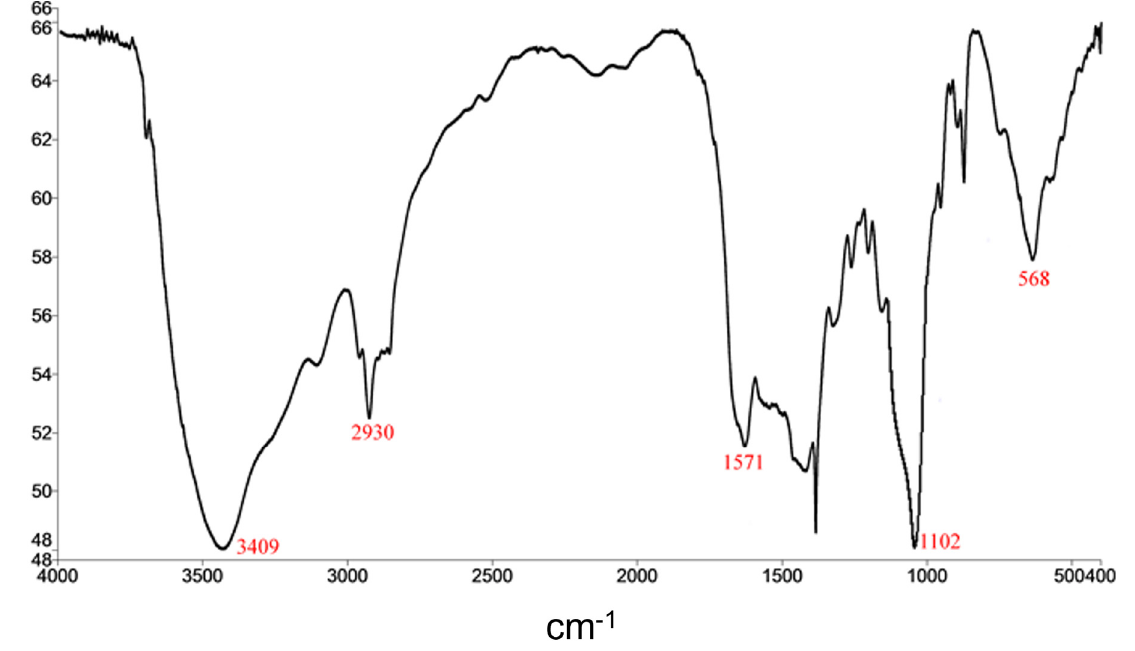
Figure 2. FT-IR spectrum of SPION@CS-IL catalyst.